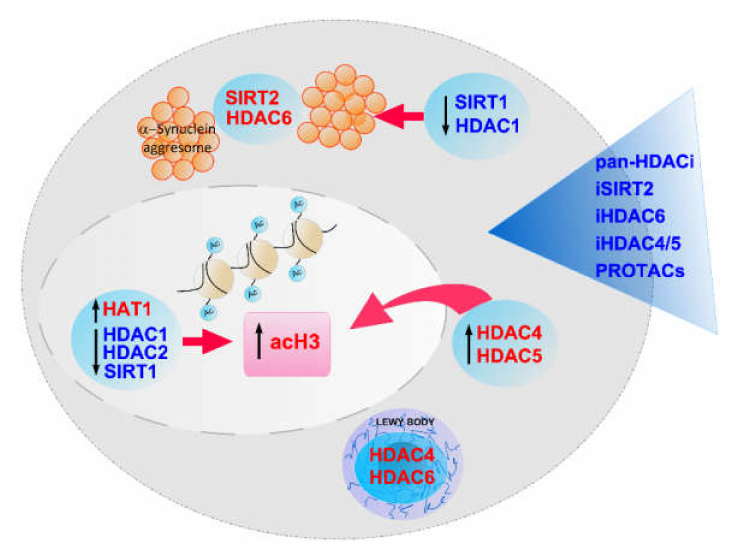
Figure 3. Histone deacetylases and their inhibitors discussed in this article. HDAC6, SIRT2, as well as HDAC4/5 appear to be promising targets for treating